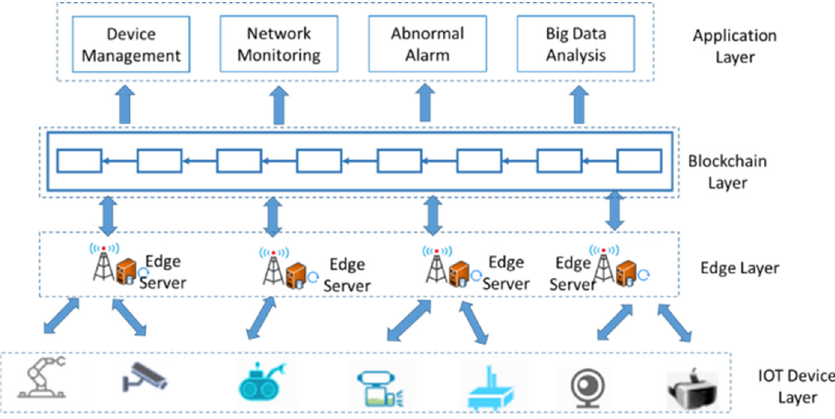
Figure 5. Asynchronous federal learning system based on permissioned blockchain.